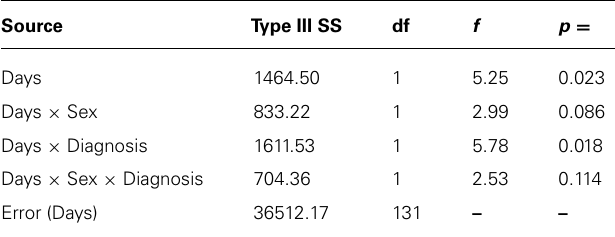
Table 1 | Summary statistics for the within subject contrasts for the 2 [Days] × 2 [Sex] × 2 [Diagnostic Group]ANOVA with Food Consumption as the dependent variable.